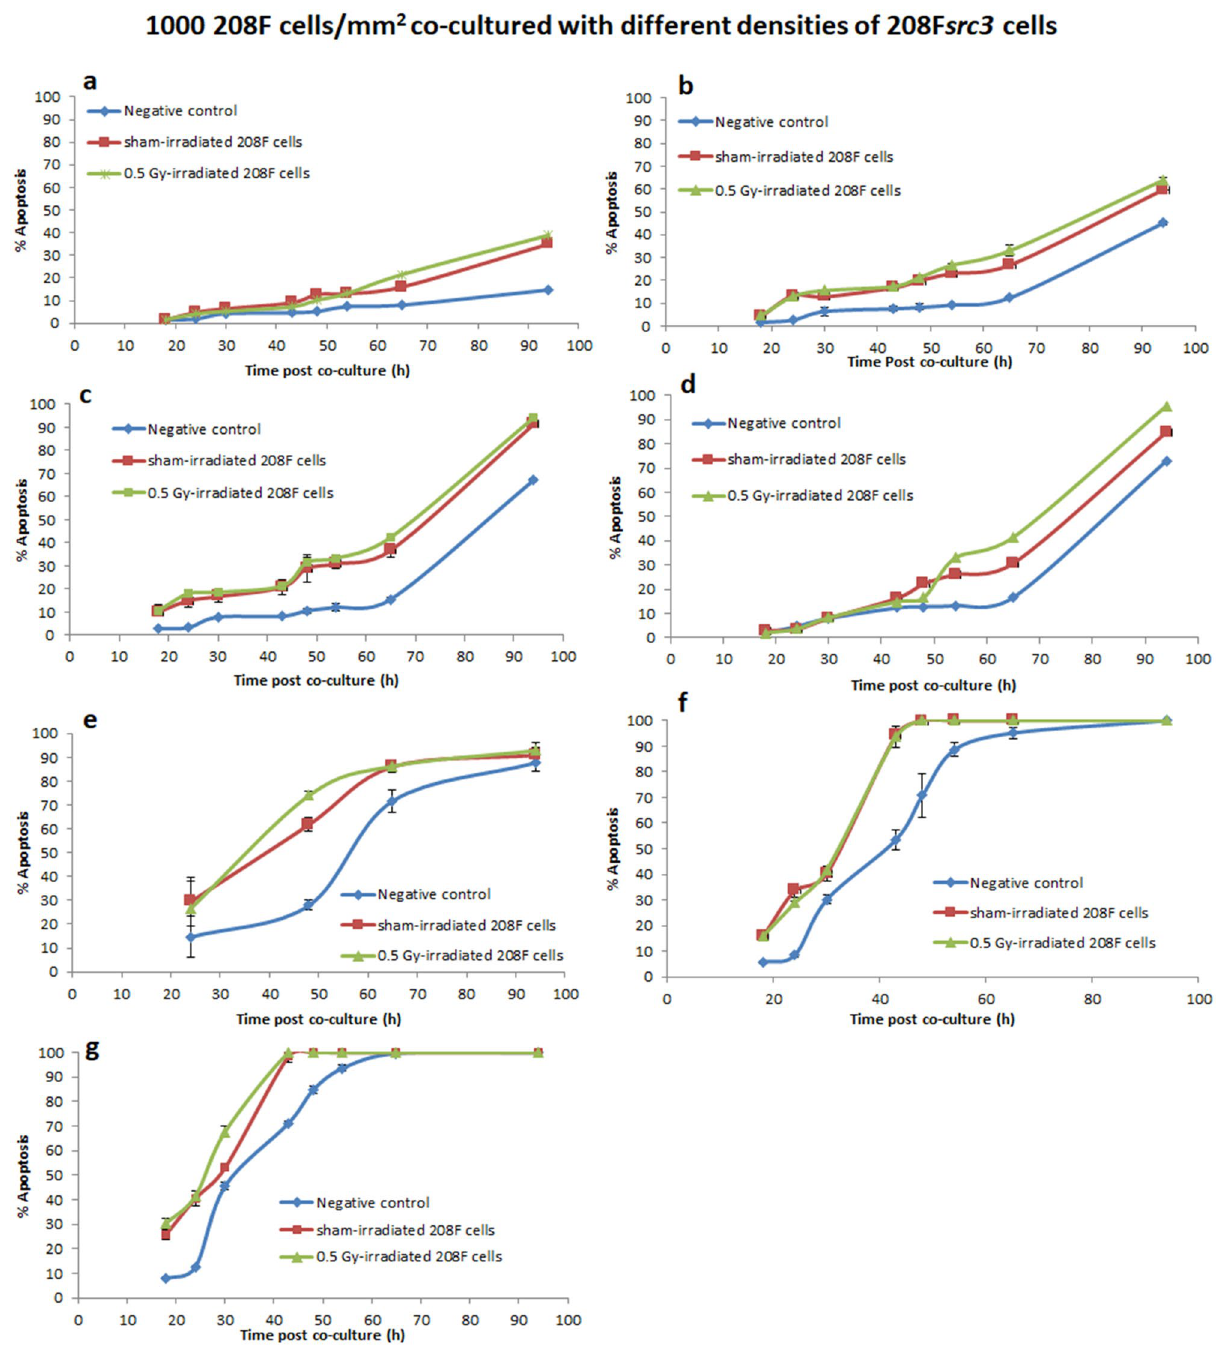
Figure 4. High density 208F cells and varying density of 208F src3 cells. Apoptosis induction in transformed 208F src3 cells seeded at densities of ( a ) 10, ( b ) 50, ( c ) 100, ( d ) 110, ( e ) 250, ( f ) 500 and ( g ) 1000 cells/mm 2 cultured in the absence or presence of sham- or 0.5 Gy γ-irradiated non-transformed 208F cells at a seeding density of 1000 cells/mm 2 . Each data point is a mean value derived from three independent experiments. Error bars represent the standard deviation derived from three independent